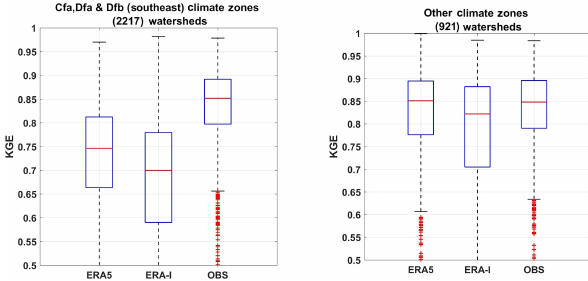
Figure 13. Distribution of the Kling–Gupta efficiency metrics for the 3 north-eastern US climate zones (Cfa, Dfa, Dfb) and for all the other 10 climate zones grouped together, for hydrological model